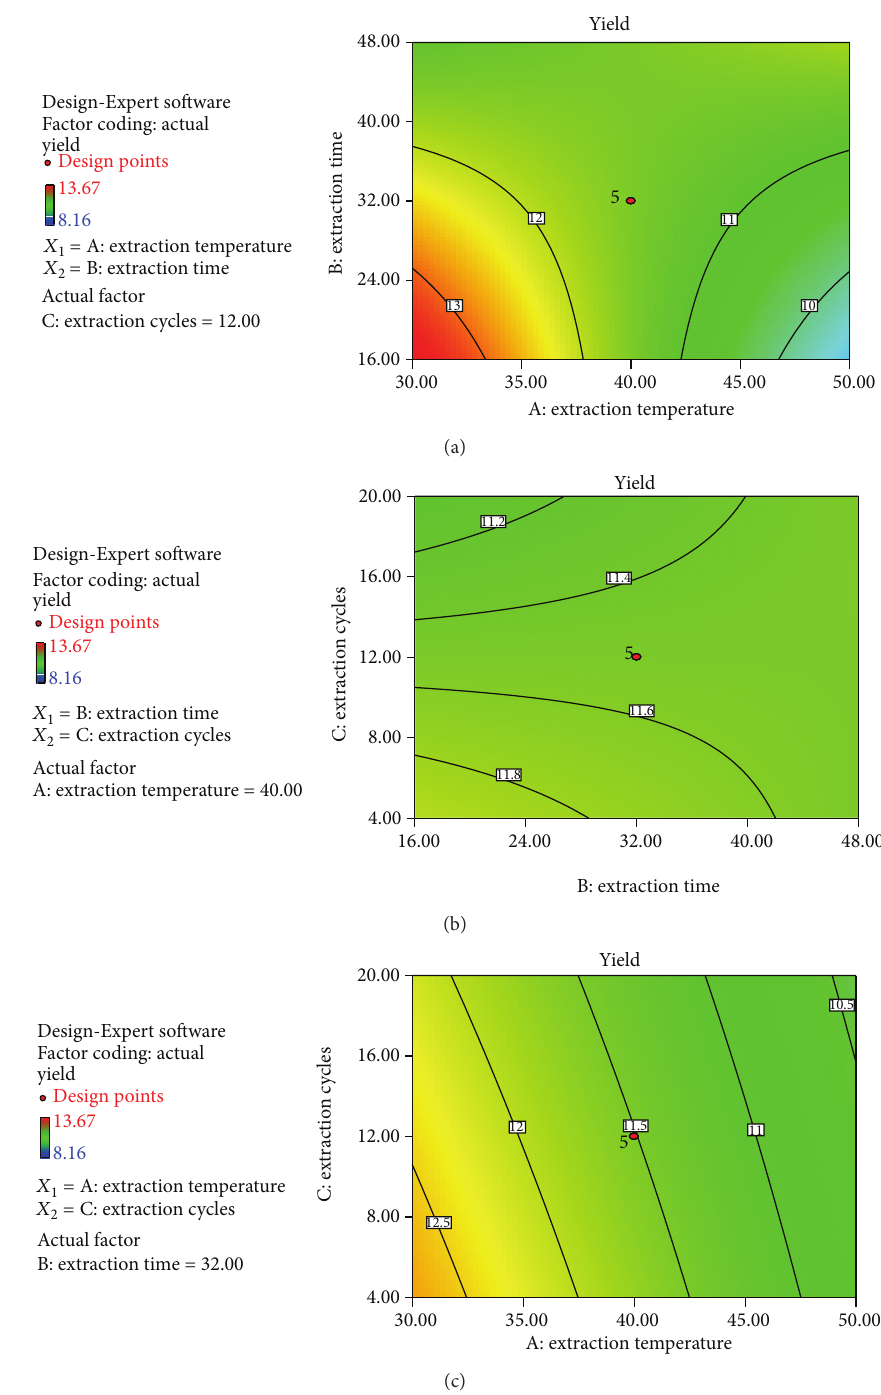
Figure2:Contourplotsshowingtheeffectofextractiontemperature,extractiontime,andextractioncycleontheyieldof Tinospora cordifolia .